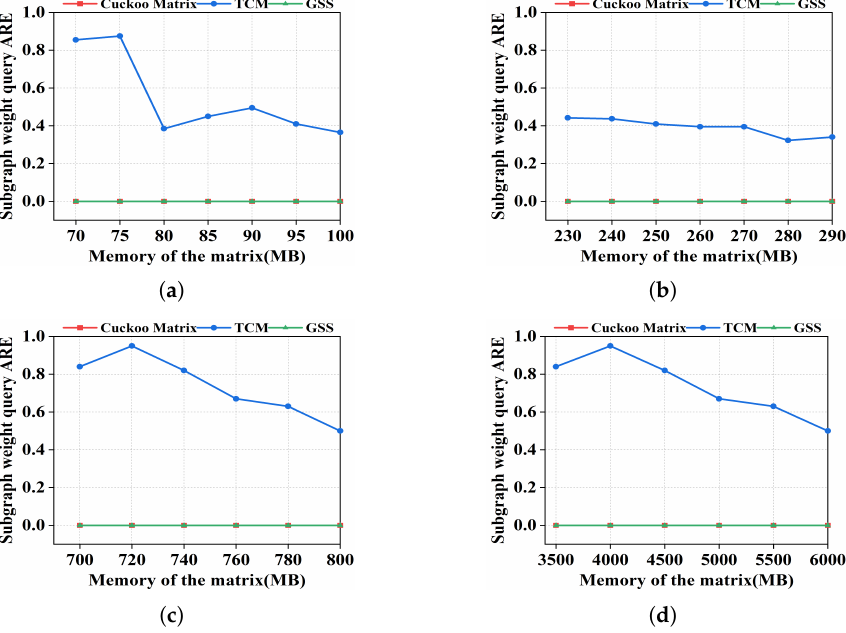
Figure 10. Average relative error of subgraph weight queries. ( a ) Skitter. ( b ) DBLP. ( c ) Orkut. ( d )